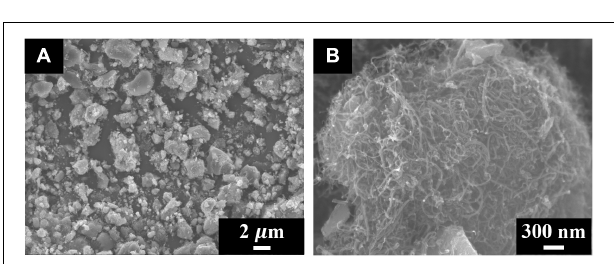
Frontiers in Materials |